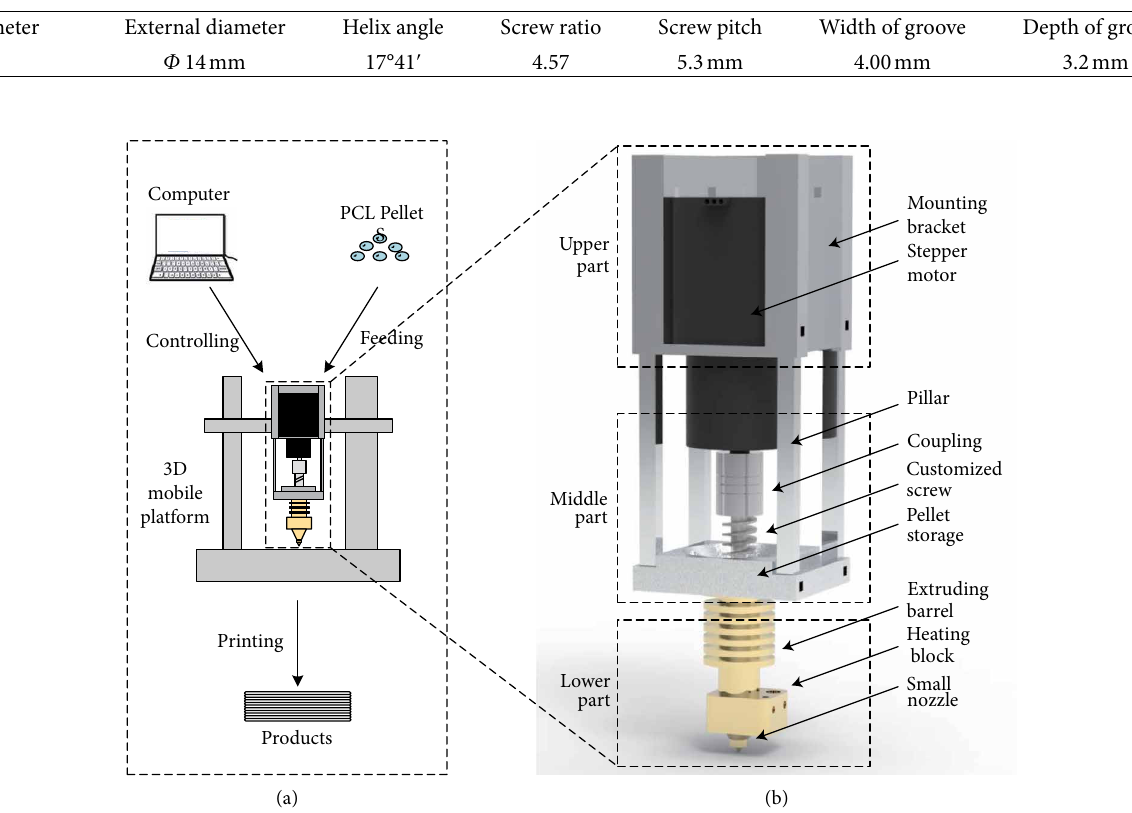
Table 1: Parameters of the customized screw.